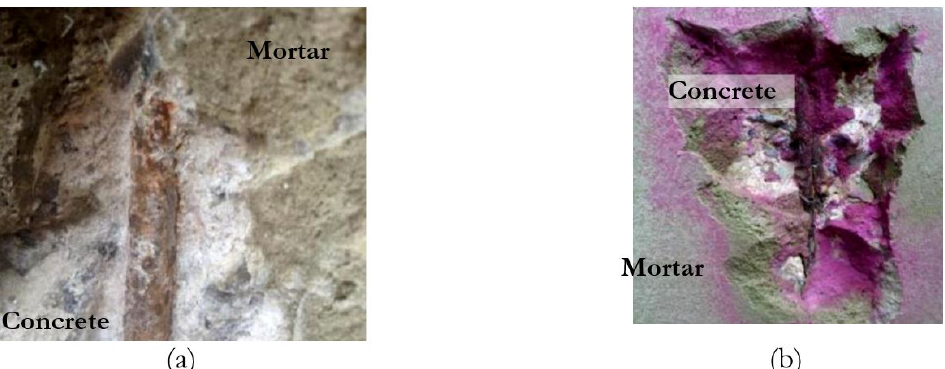
Figure 7. Exposed reinforcement during inspection: (a) on Repair 3 of SW façade and (b) on Repair 2 of NW façade (Photos: Authors’ collection,